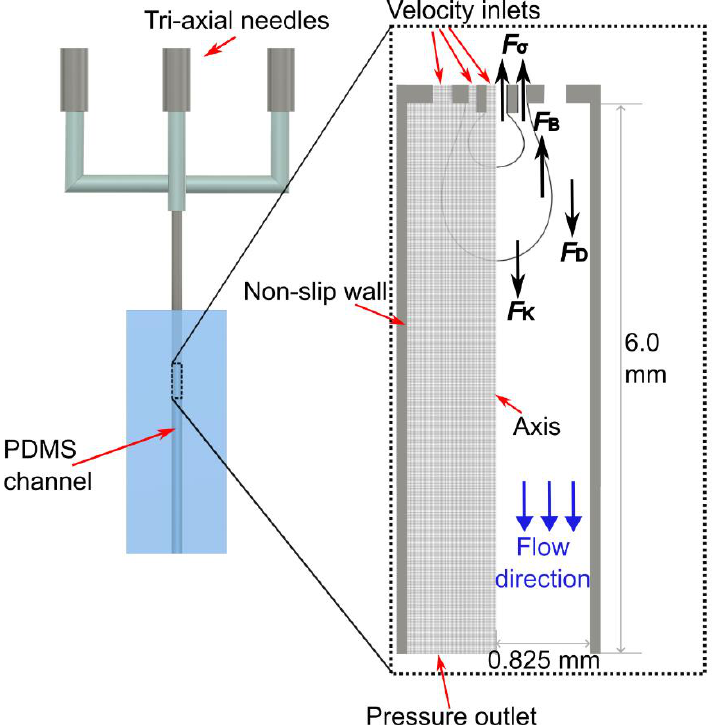
Figure 3. Schematic illustration of the computational domain, structural mesh, and forces exerting on a growing double emulsion droplet.